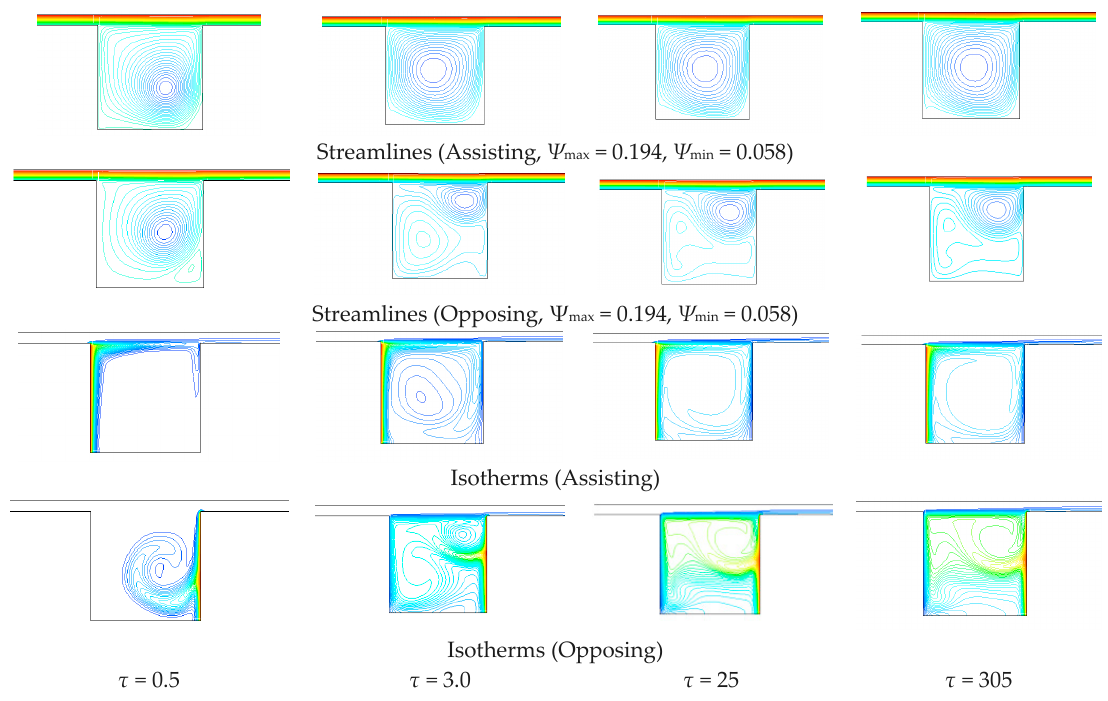
Figure 12. Streamlines and isotherms for Re = 1000, aspect ratio (AR) = 1.0 and Ri = 6.58.